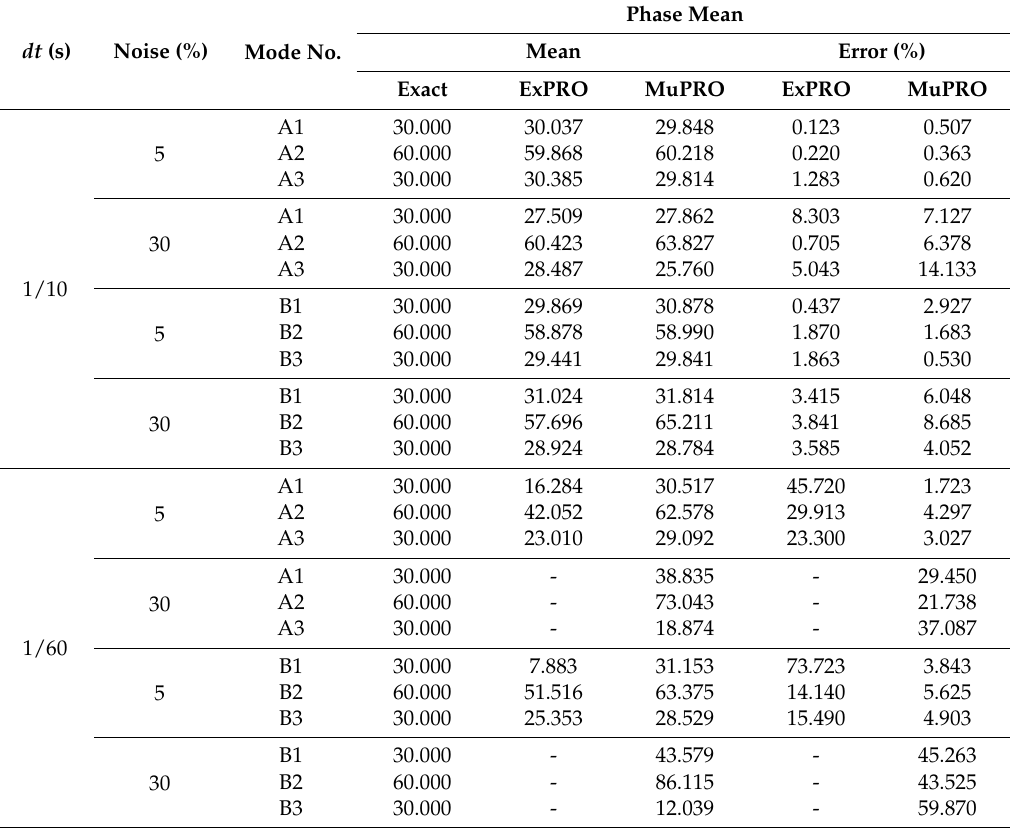
Table 5. Estimated phase mean.